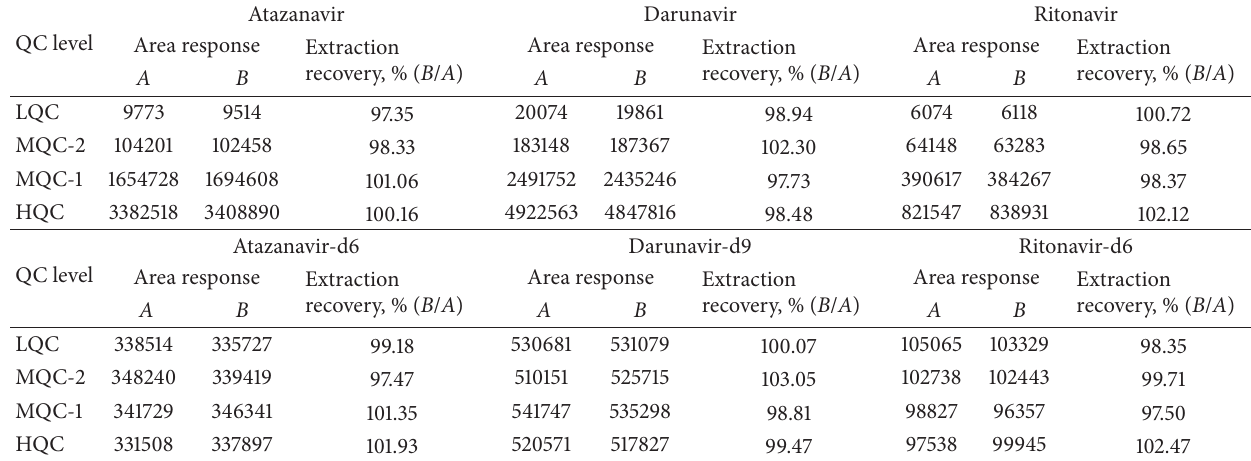
Table 3: Extraction recovery of atazanavir, darunavir, and ritonavir from human plasma.